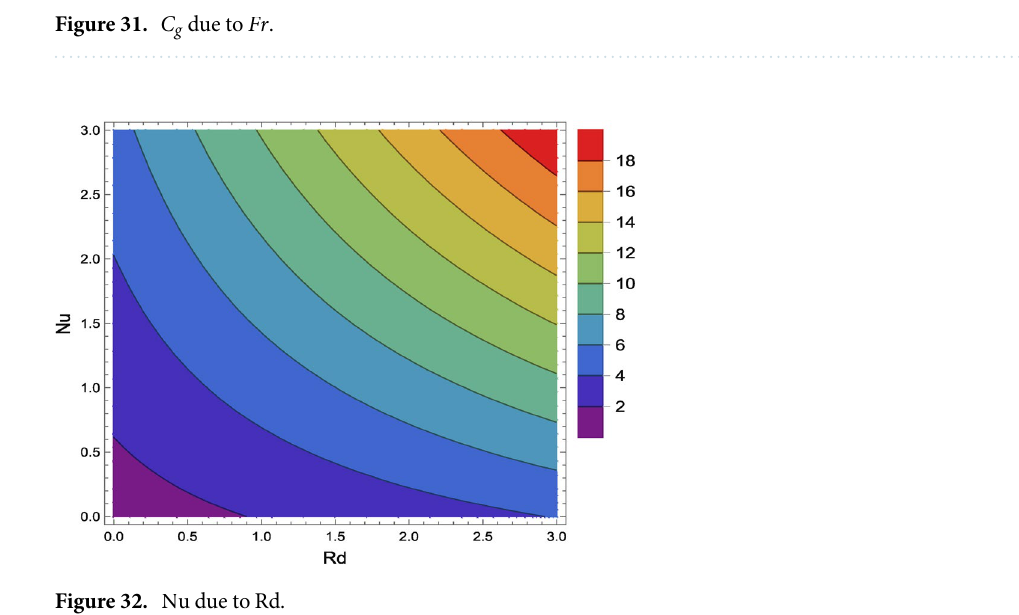
Figure 32. Nu due to Rd